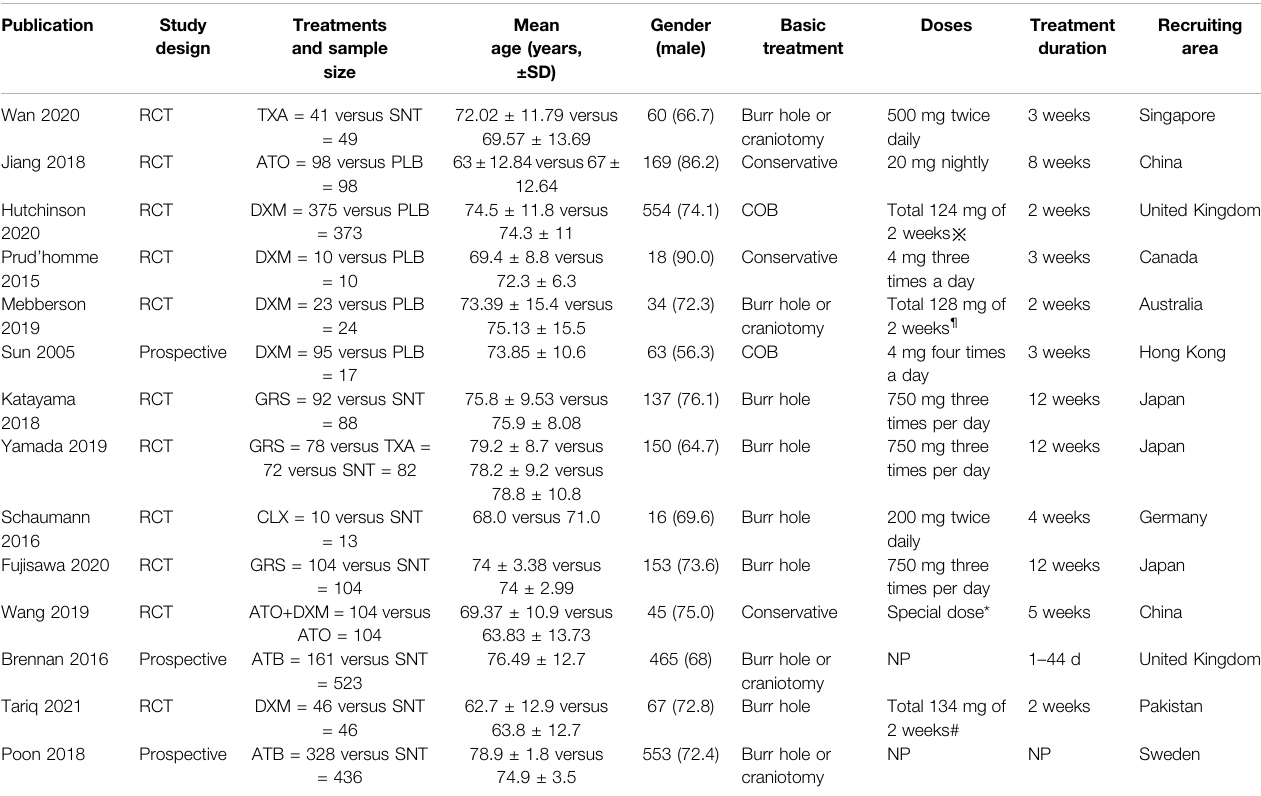
TABLE 1 | Characteristics of included